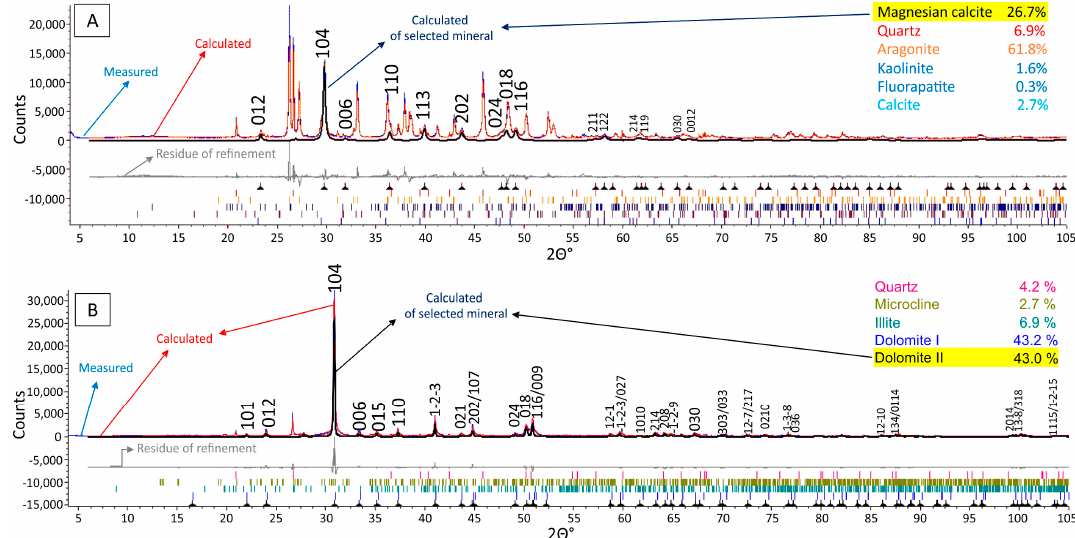
Figure 3. Refinement result for samples with the abundant ( A ) magnesian calcite in sample AC3623 and ( B ) non-stoichiometric dolomite in sample C14. The blue and red curves are measured and calculated diffraction pattern, respectively. The black curve is the diffraction pattern for the highlighted mineral. The gray curve is the residue of the refinement, followed by the position of the crystallographic reflections of quantified minerals following order and color code of the list in the upper right corner. The miller indexes for reflections refer to the highlighted minerals in ( A , B ).